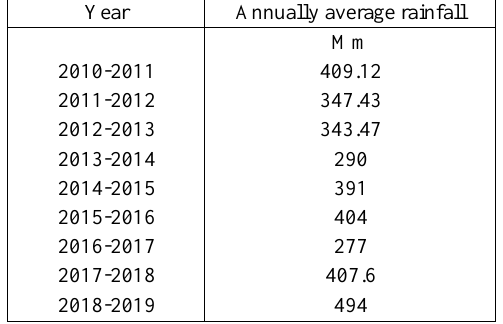
Table 4. Annually Average of rainfall